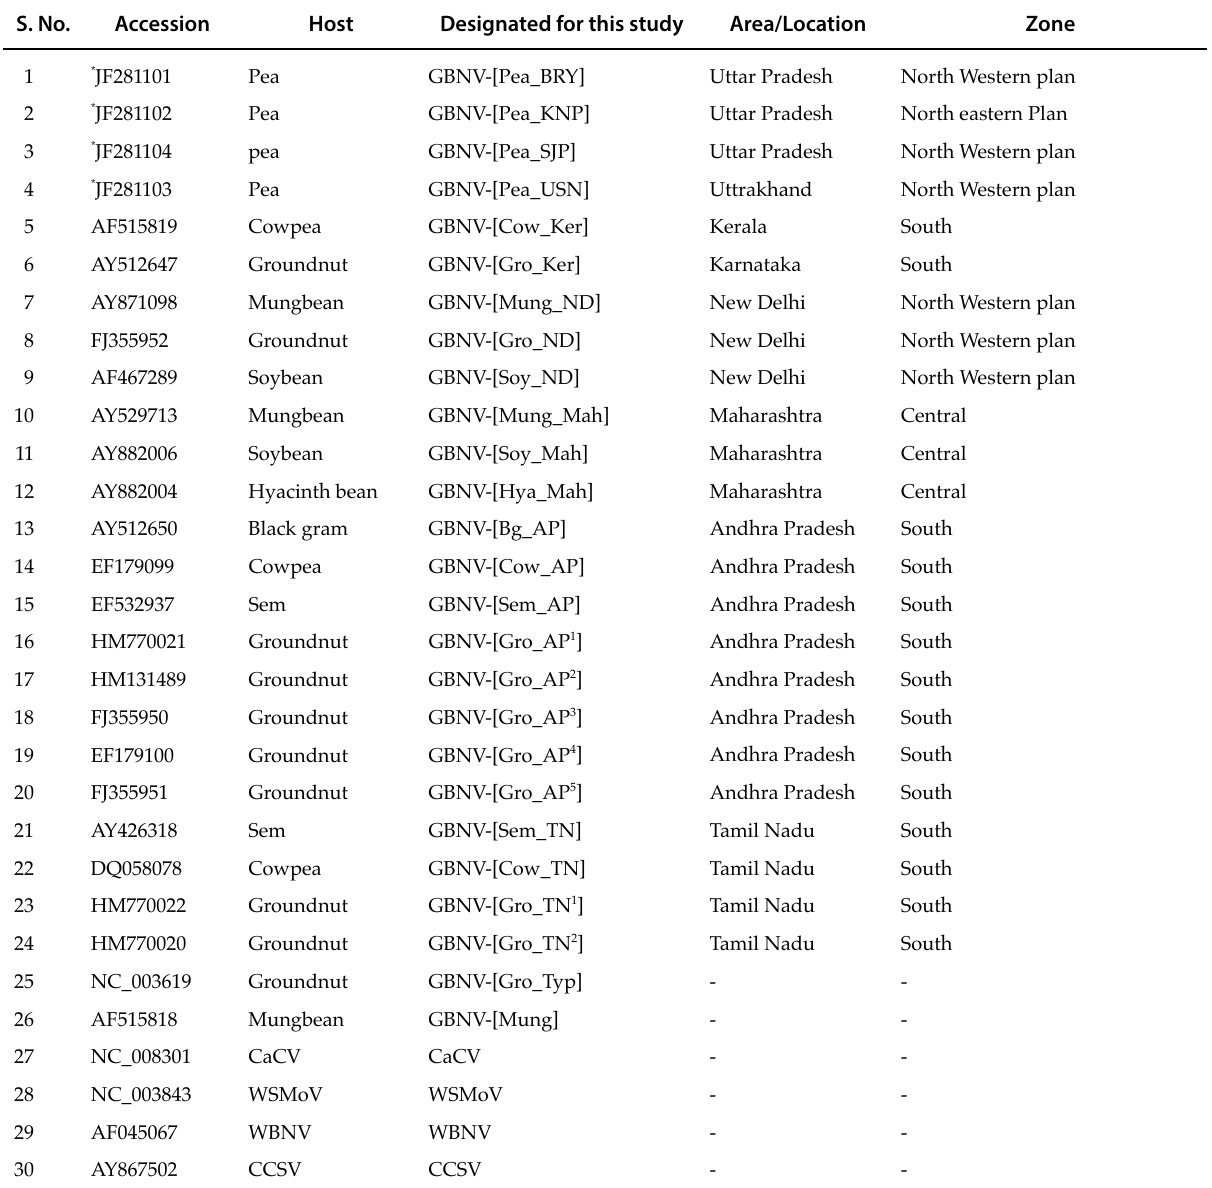
Table 1. Details of the NP gene sequences used in this study. S.